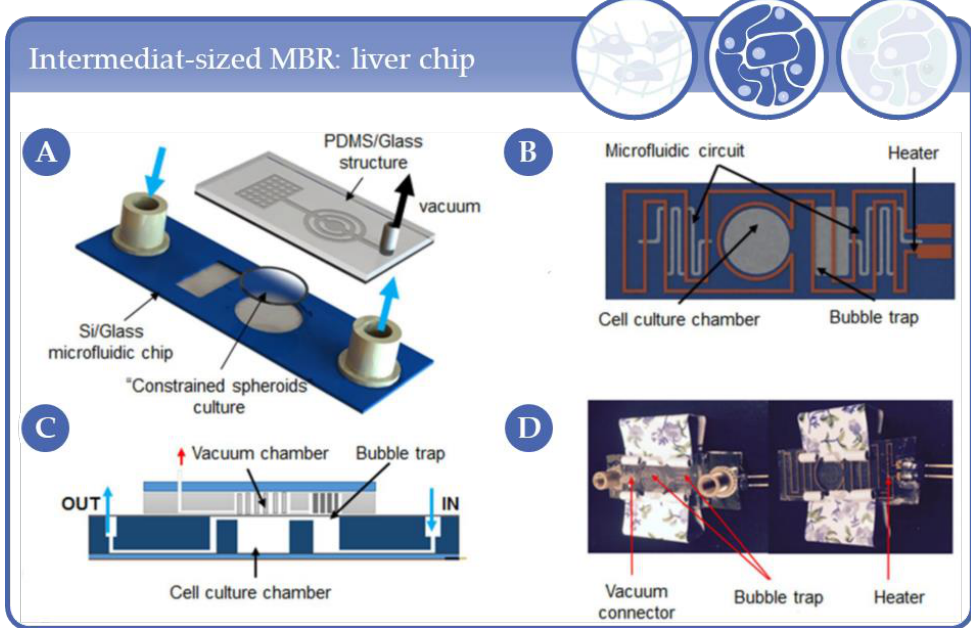
Figure 13. Schematic of the perfusion incubator liver chip (PIC) chip. ( A ) 3D view with the PIC. A glass/silicon structure containing a 3D microfluidic circuit, the cell culture chamber, a bubble trap chamber as well as a heater. ( B ) Bottom view of the chip’s layout illustrating the microfluidic circuit, the cell culture chamber, the bubble trap and the heater. ( C ) Cross-section of the PIC illustrating the structure of the bubble trap. It consists of a 70 μm-thick PDMS membrane (gas permeable) bonded to a PDMS molded chamber with pillars that support the membrane. The PDMS structure is connected to external vacuum (through a pressure controller). The gas bubbles trapped in the microwell can diffuse through the PDMS membrane due to negative pressure in the vacuum chamber while culture media remains inside the culture chamber. ( D ) Top and bottom view of the PIC. Reprinted from [126] with permission of Elsevier.